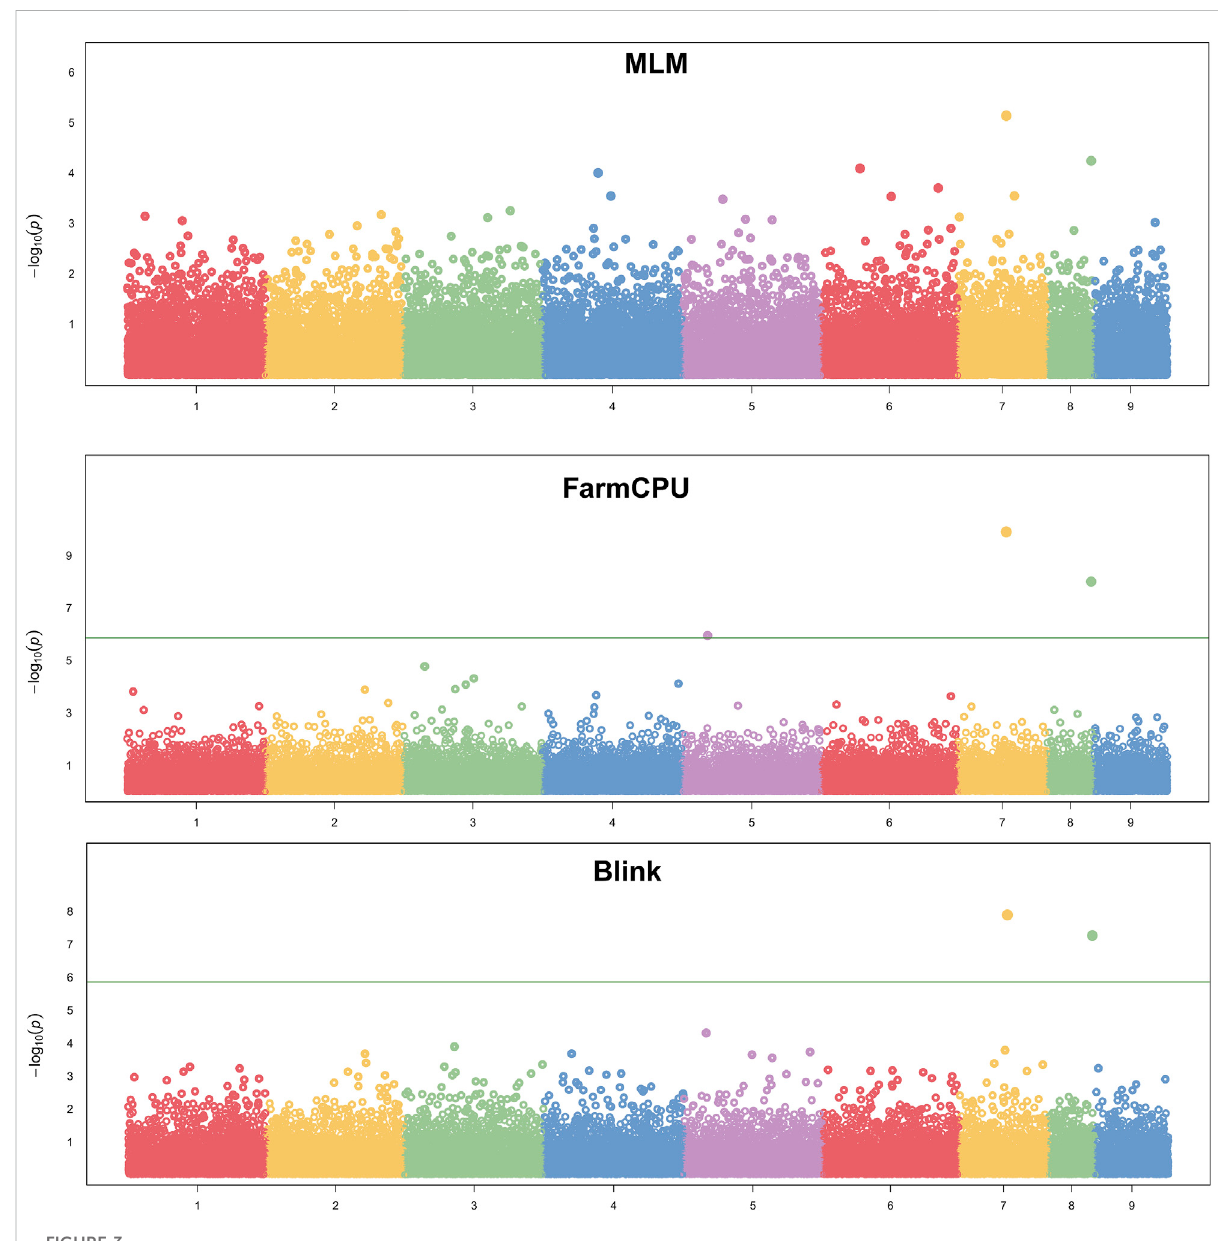
FIGURE 3 Manhattan plot of − log 10 P for the GWAS of ammonia nitrogen